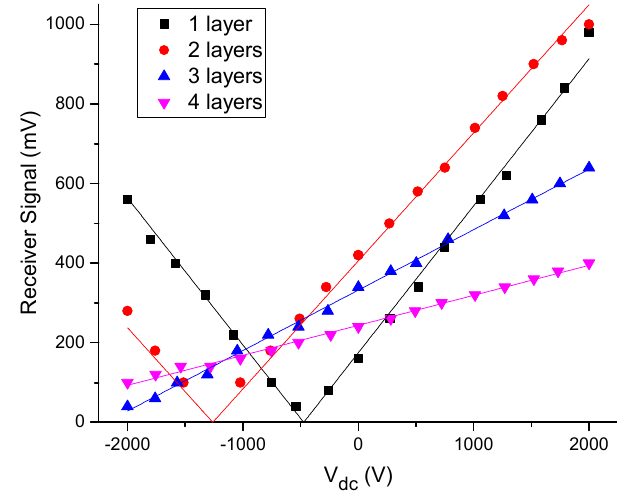
Figure 3. Peak-to-peak signals received with a high-voltage module versus bias-voltage V dc